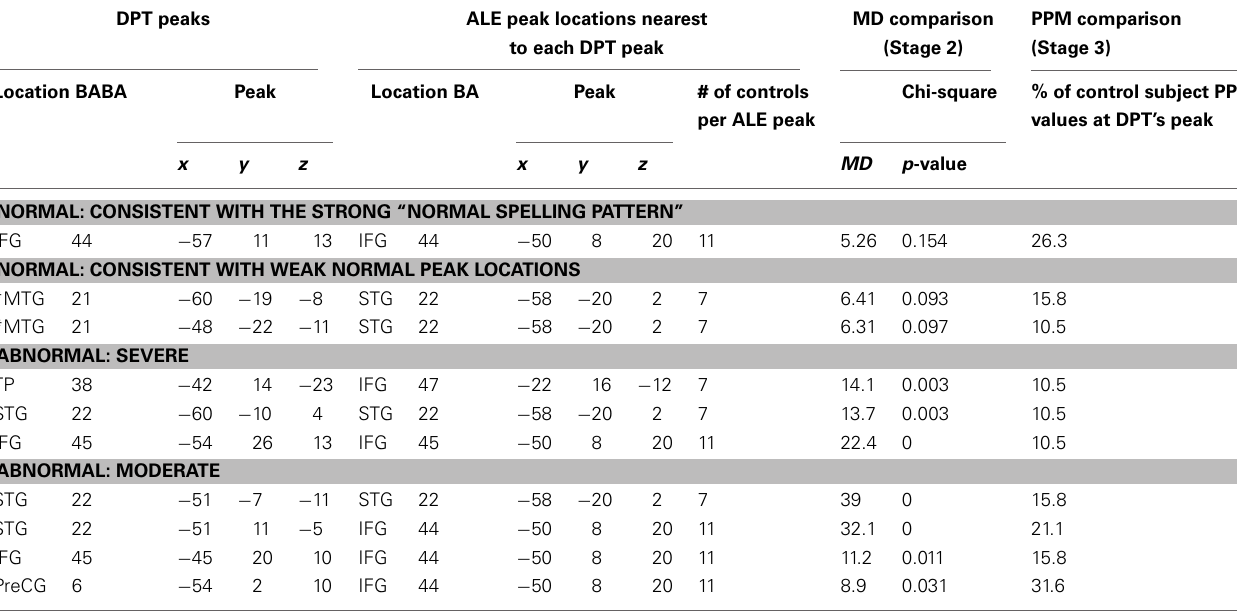
Table 6 | Characterization of the locations of all of DPT’s peaks relative to control group peak locations based on stage 2 and 3